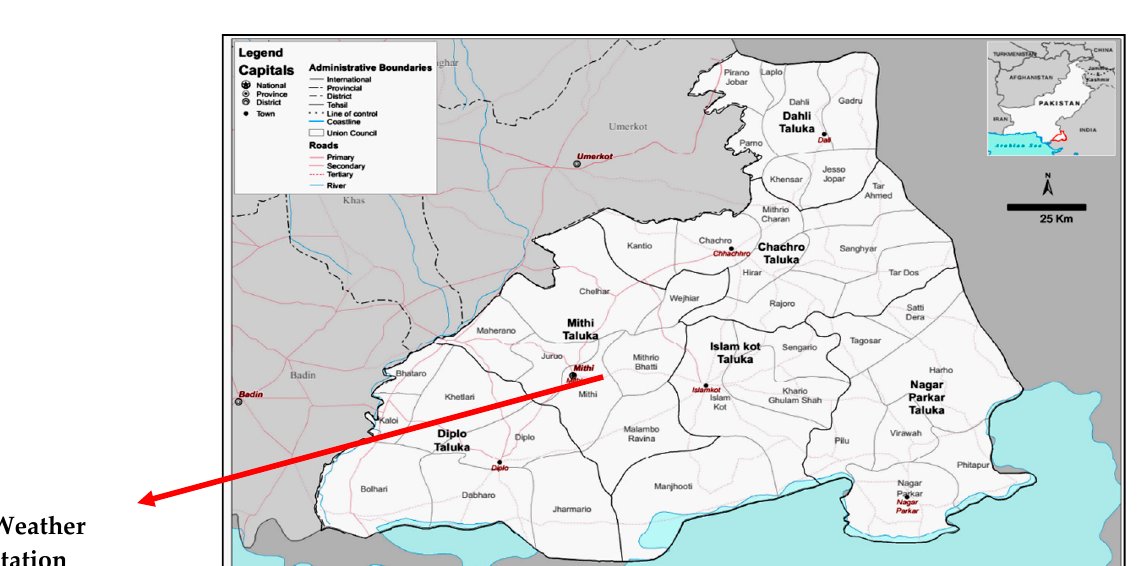
Figure 2. Location of Mithi weather station (Meteorological Station); the data is collected for this station that was established in 2004.